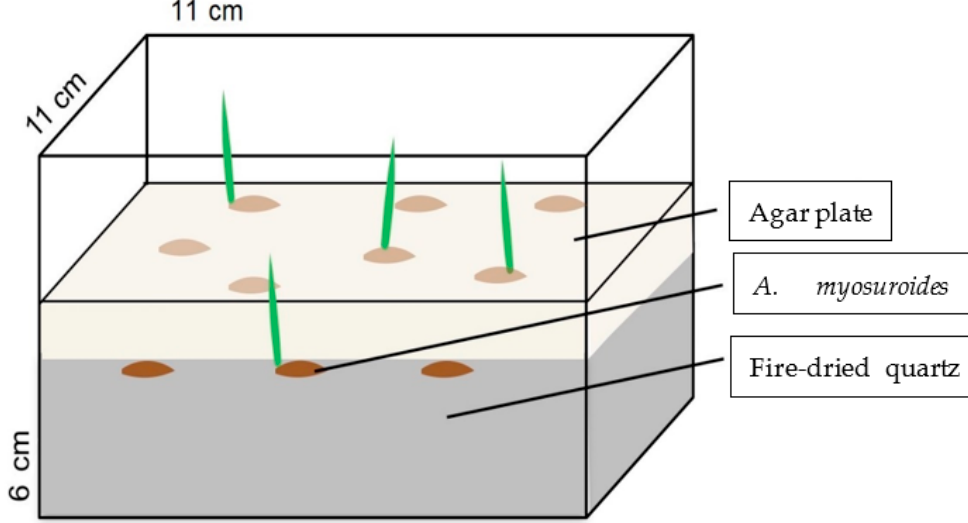
Figure 3. Structure of the agar test: 1st layer = fire-dried quartz sand.; 2nd layer = pre-germinated A. myosuroides seeds; 3rd layer = agar plate consisting of agar, herbicide and nutrients.